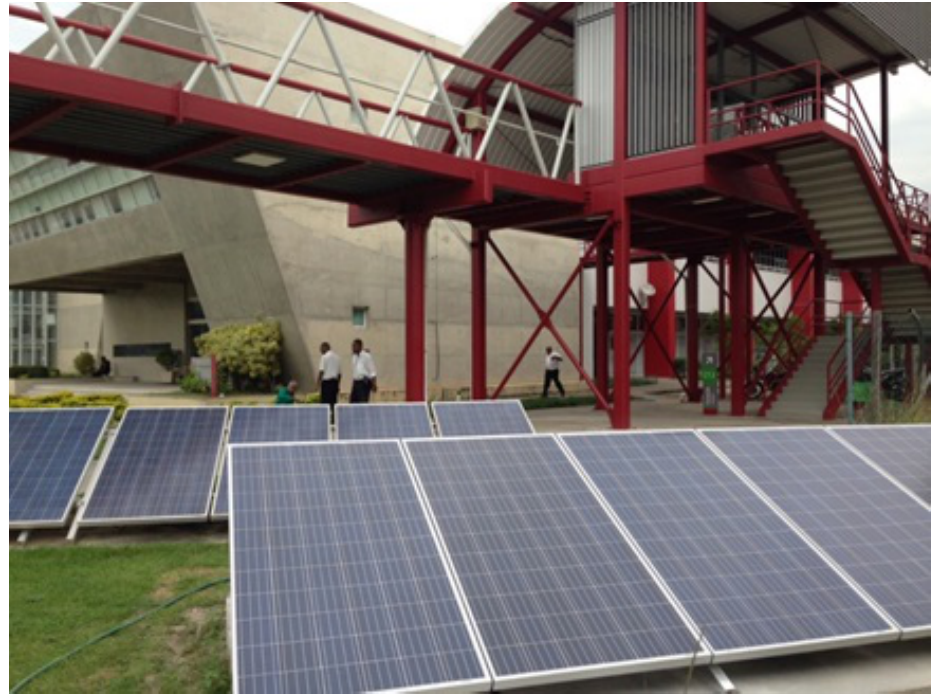
Figure 8. Twelve solar panels of 250 Wp each (total of 12